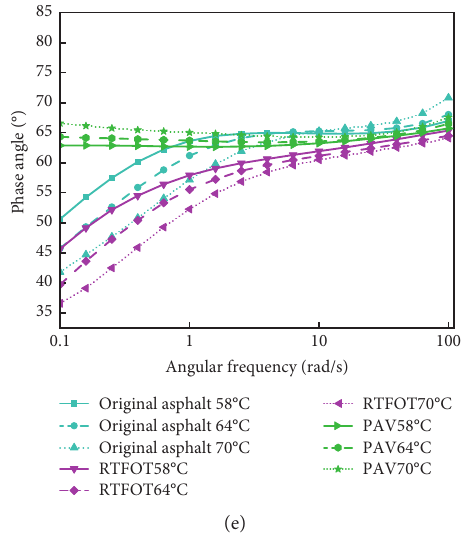
Figure 7: Frequency sweep phase angle of each asphalt. (a) K1. (b) K2. (c) G1. (d) G2. (e)